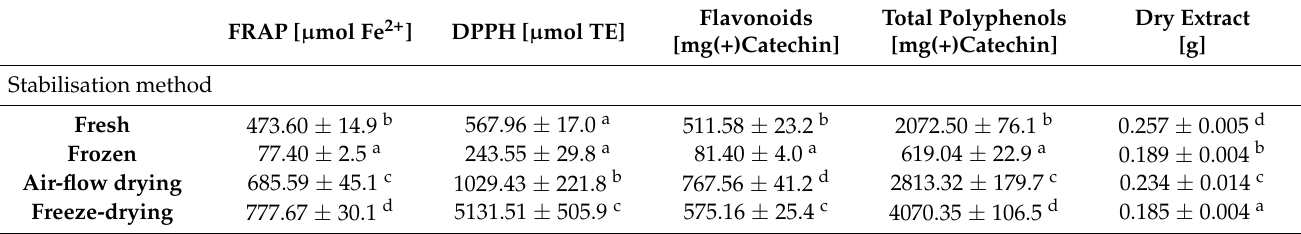
Table 1. The influence of the stabilisation methods of raw material on the antioxidant properties of the elderflower extracts (FRAP, DPPH), the total contents of flavonoids and polyphenols, and the content of the dry extract in grams (SE ± , n = 96).